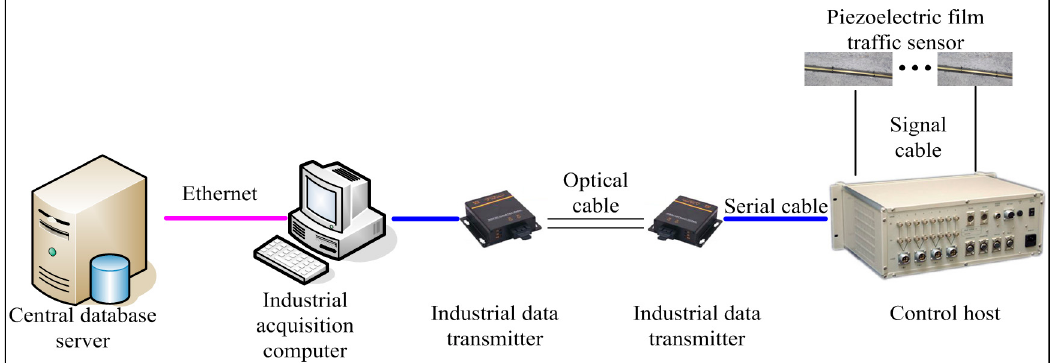
Figure 7. Flowchart of data acquisition and transmission network topology for traffic flow.